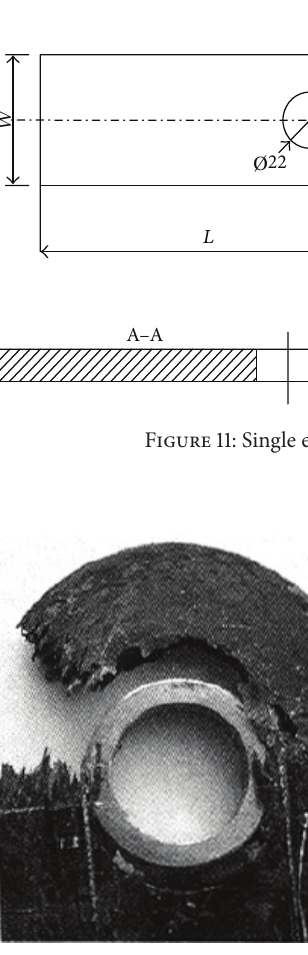
Figure 12: Lug joint failure pattern and the stress distribution.